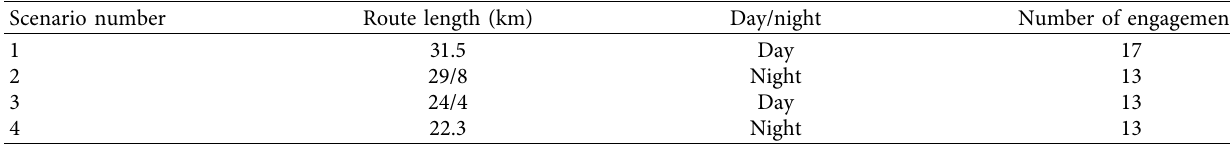
Figure 1: A view of the driving simulator and a driver taking the test. Table 1: Test scenario